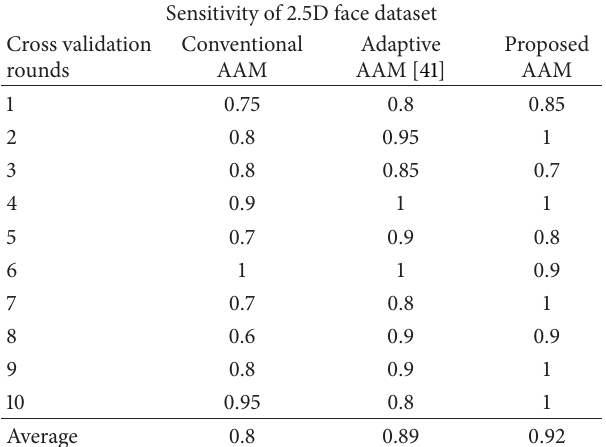
Table 9: Cross validation results for CASIA face dataset in terms of specificity for conventional AAM, adaptive AAM, and the proposed AAM.